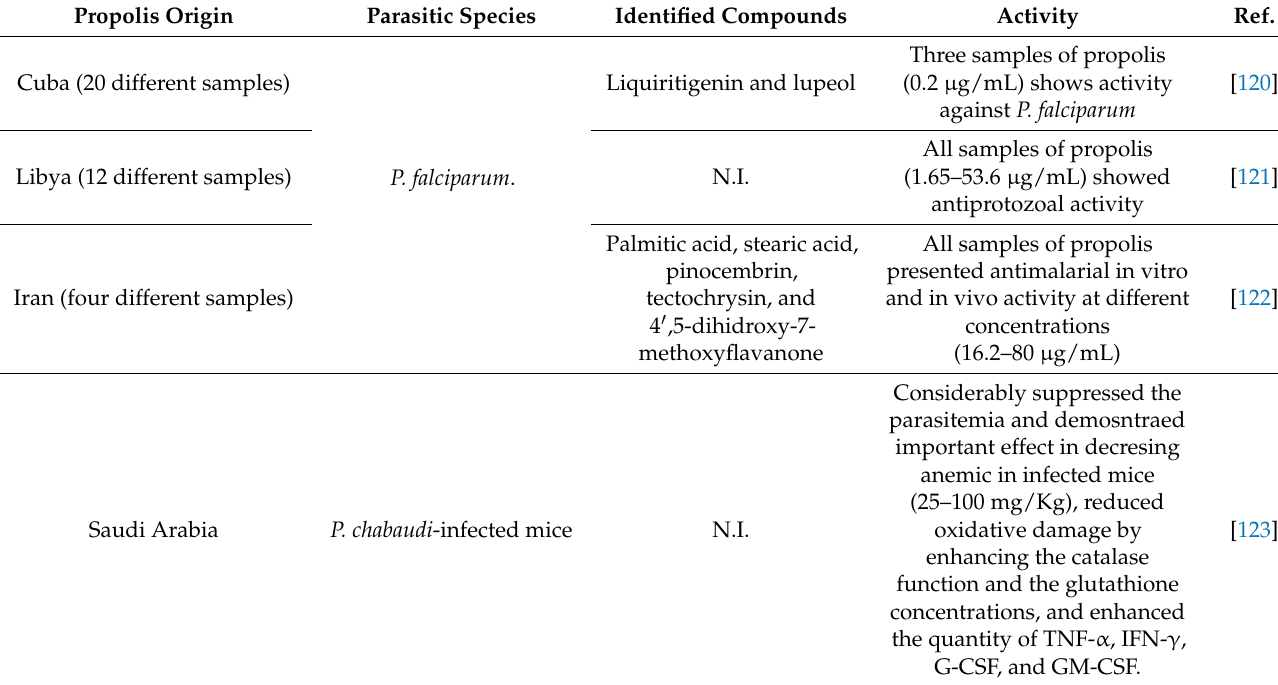
Table 11. Antimalarial effect of propolis and its chemical